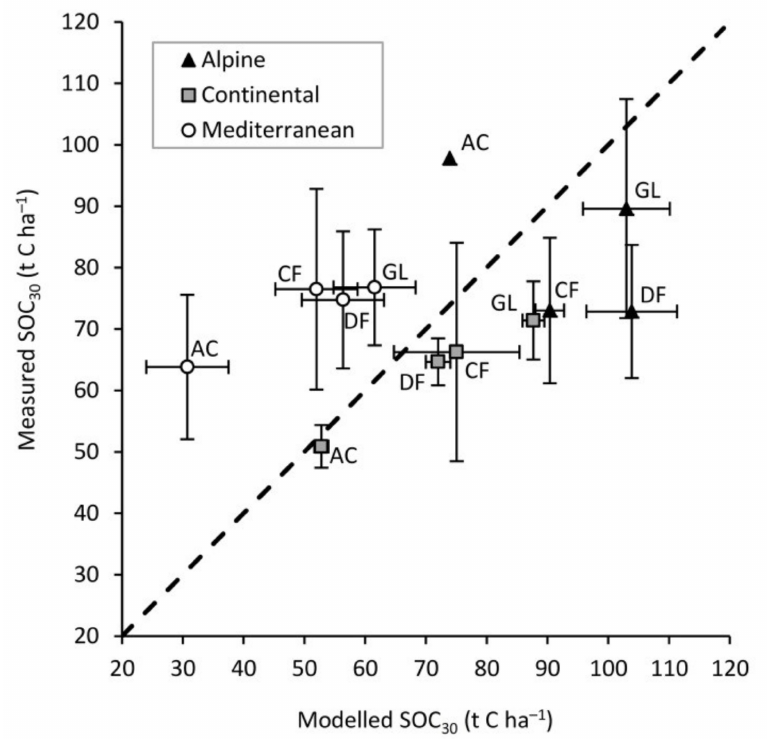
Figure 3. Comparison of measured and modelled soil organic carbon stocks down to 30 cm at the land use × biogeographical region level. Average ± 1.96 SE. The dashed line is a 1:1 line.